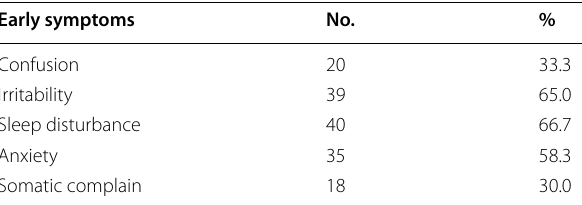
Table 3 Early symptoms of postpartum psychosis in patients’